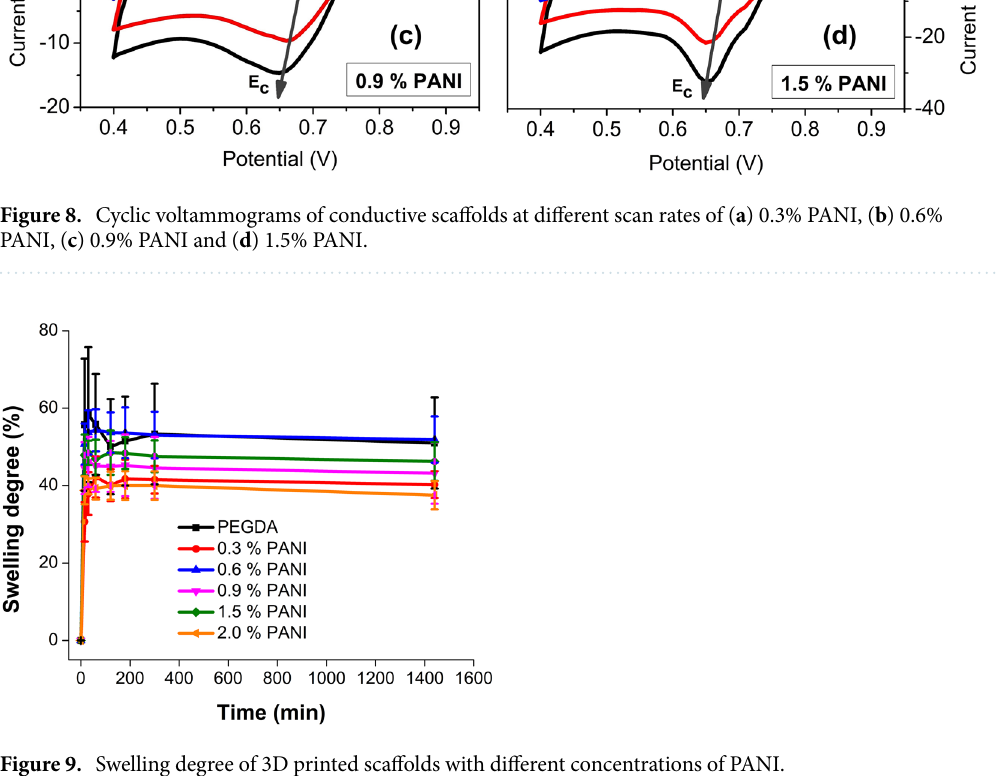
Figure 9. Swelling degree of 3D printed scaffolds with different concentrations of